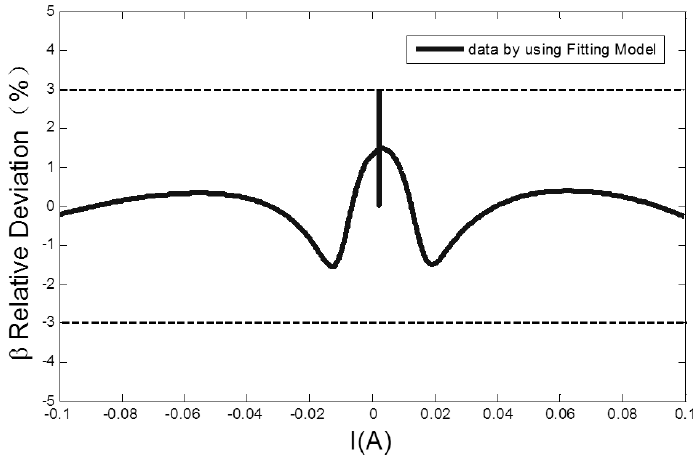
Figure 7. The relative deviation between the fitted dynamic permeability parameter and the actual dynamic permeability